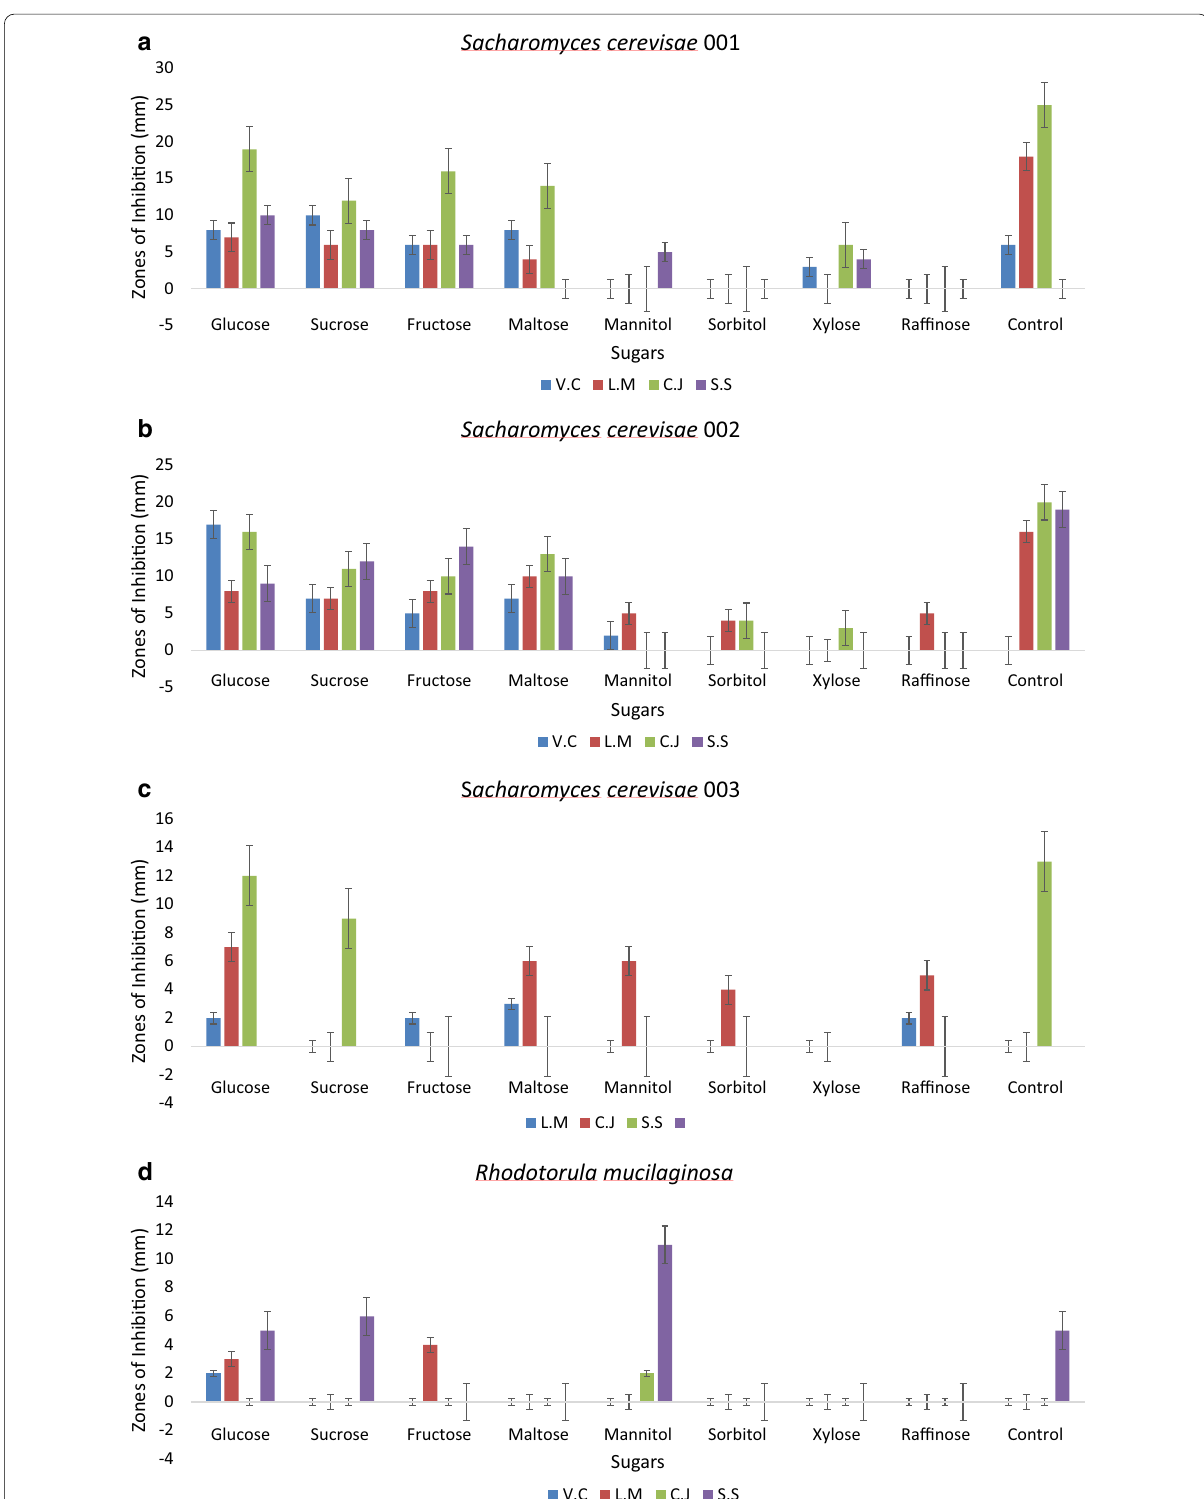
Fig. 5 a Effect of carbon sources on the antimicrobial activities of Saccharomyces cerevisiae 001 . b Effect of carbon sources on the antimicrobial activities of Saccharomyces cerevisiae 002 . c Effect of carbon source on the antimicrobial activities of Saccharomyces cerevisiae 003 . d Effect of carbon source on the antimicrobial activities of Rhodotorula